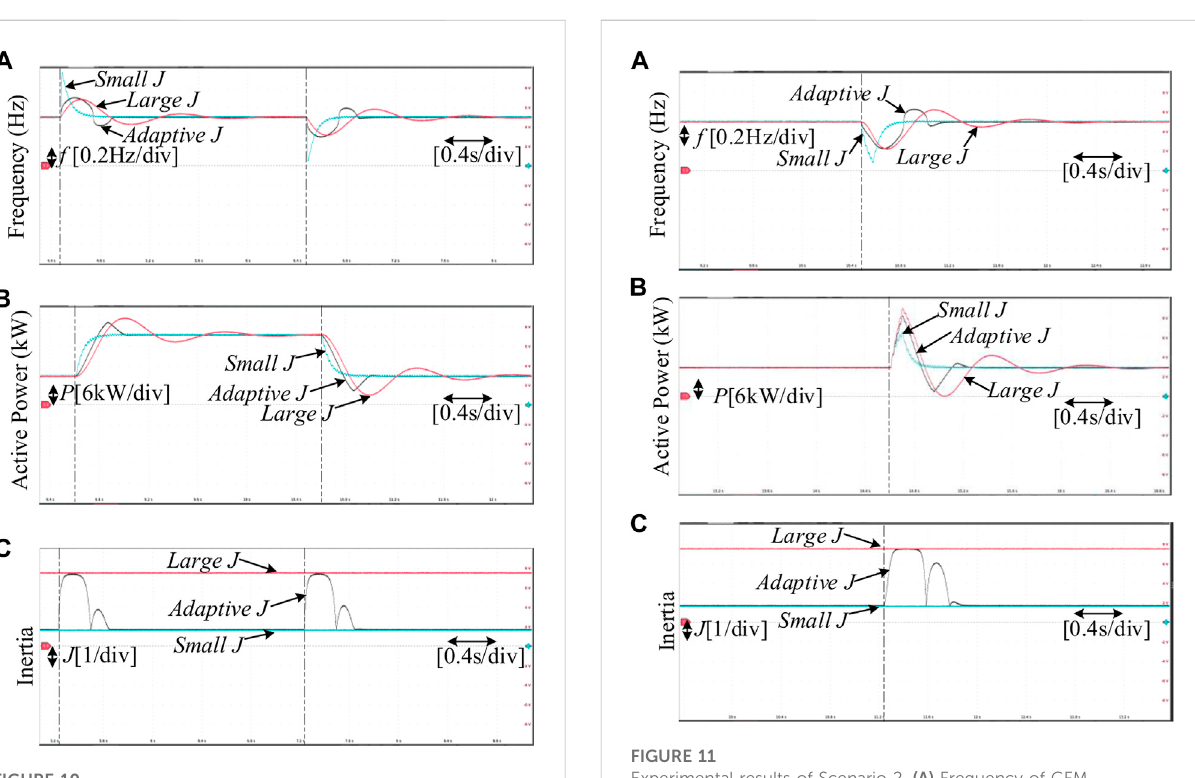
FIGURE 10 ExperimentalresultsofScenario1. (A) FrequencyofGFMinverter. (B) Active power of GFM inverter. (C) Inertia of GFM inverter.